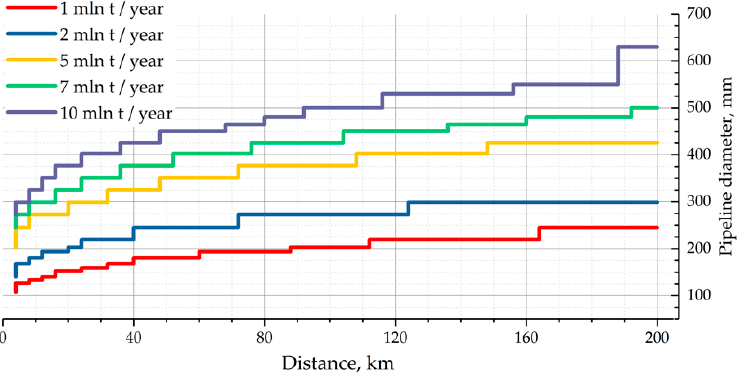
Figure 5. The relationship between transportation distance, annual CO 2 flow, and pipeline diameter.